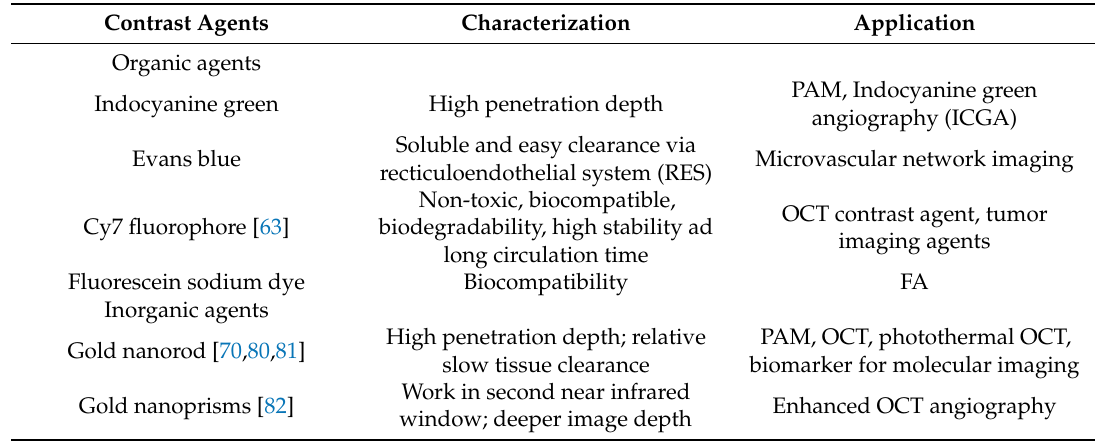
Table 3. Summarization of common contrast agents applied for photoacoustic microcopy and